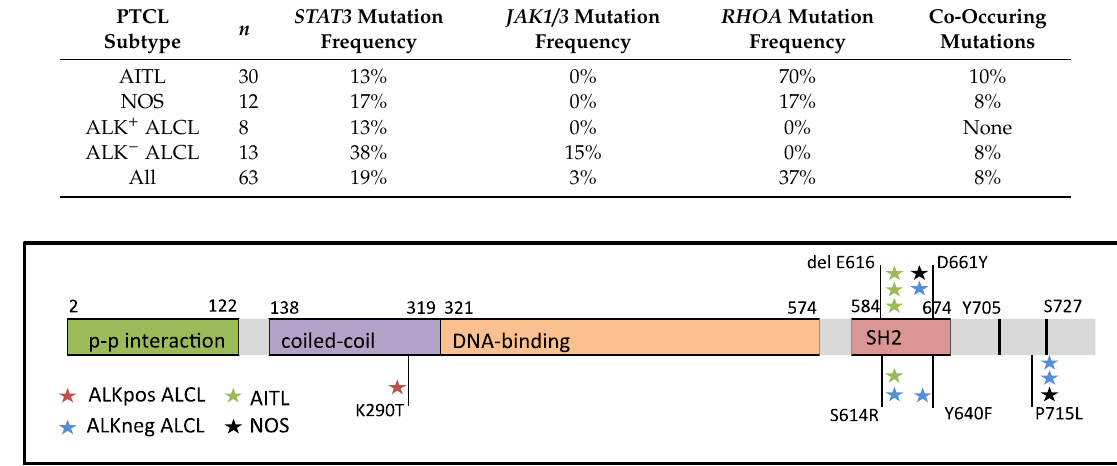
Figure 1. STAT3 structure and mutation sites in ALCL, AITL, and PTCL-NOS patients of the study Figure1. STAT3 cohort.